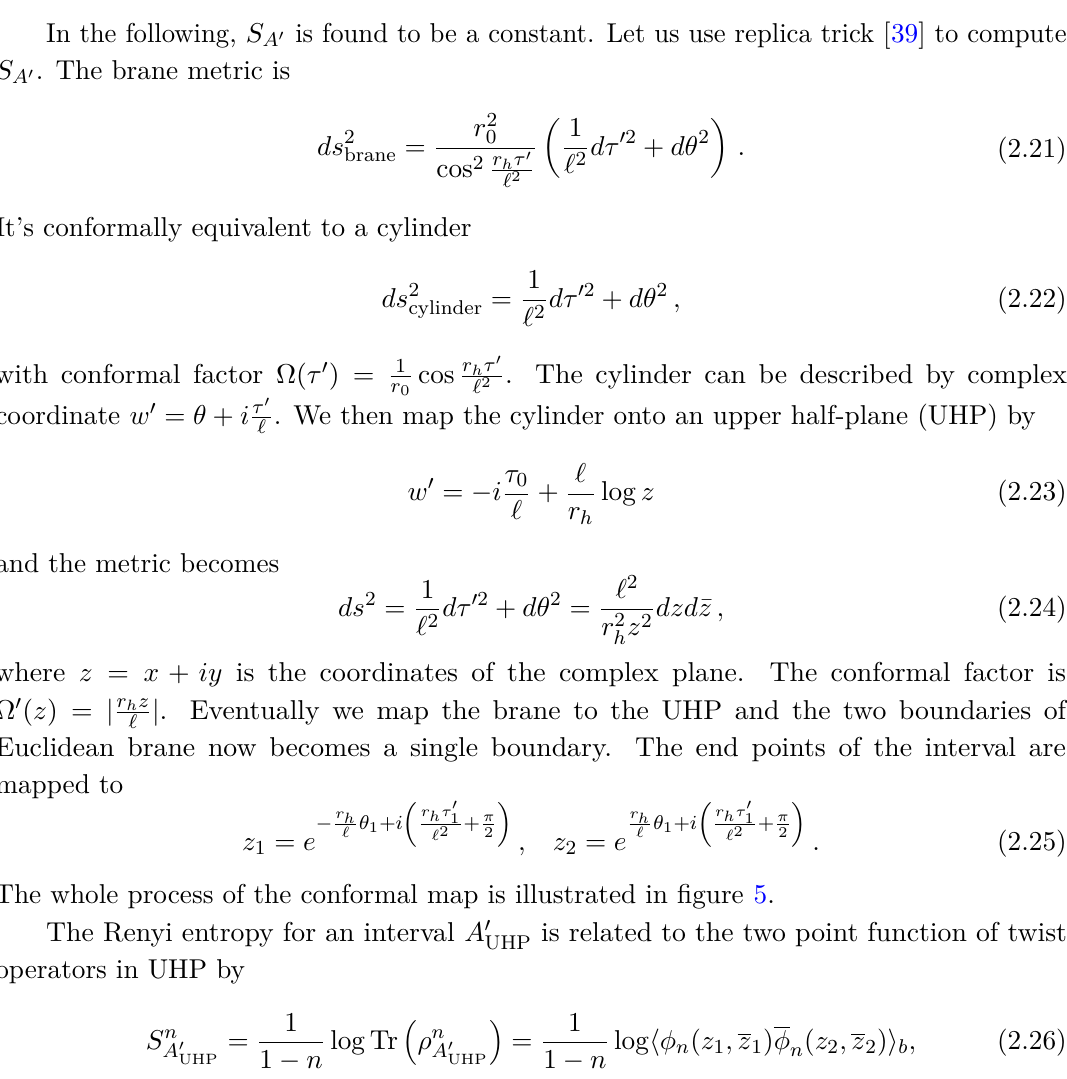
Figure 4 . An illustration of bulk DES calculation in t = t 1